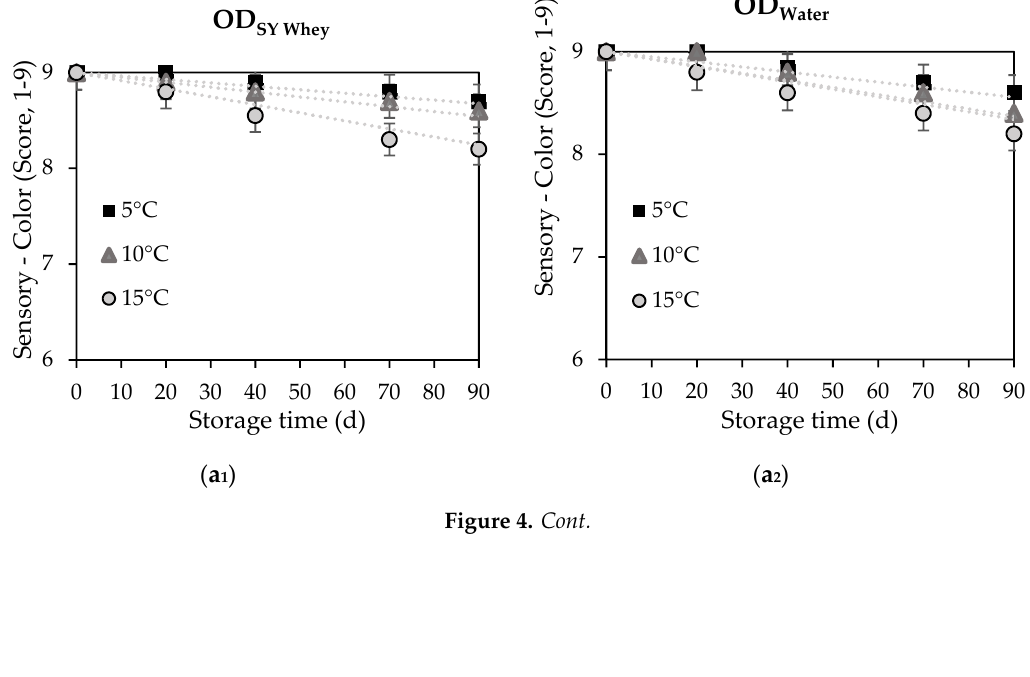
Figure 3. Pictures of pumpkin cuts ( a ) fresh, ( b ) osmotically treated in SY Whey (OD SY Whey ), and ( c ) osmotically treated in water (OD Water ).